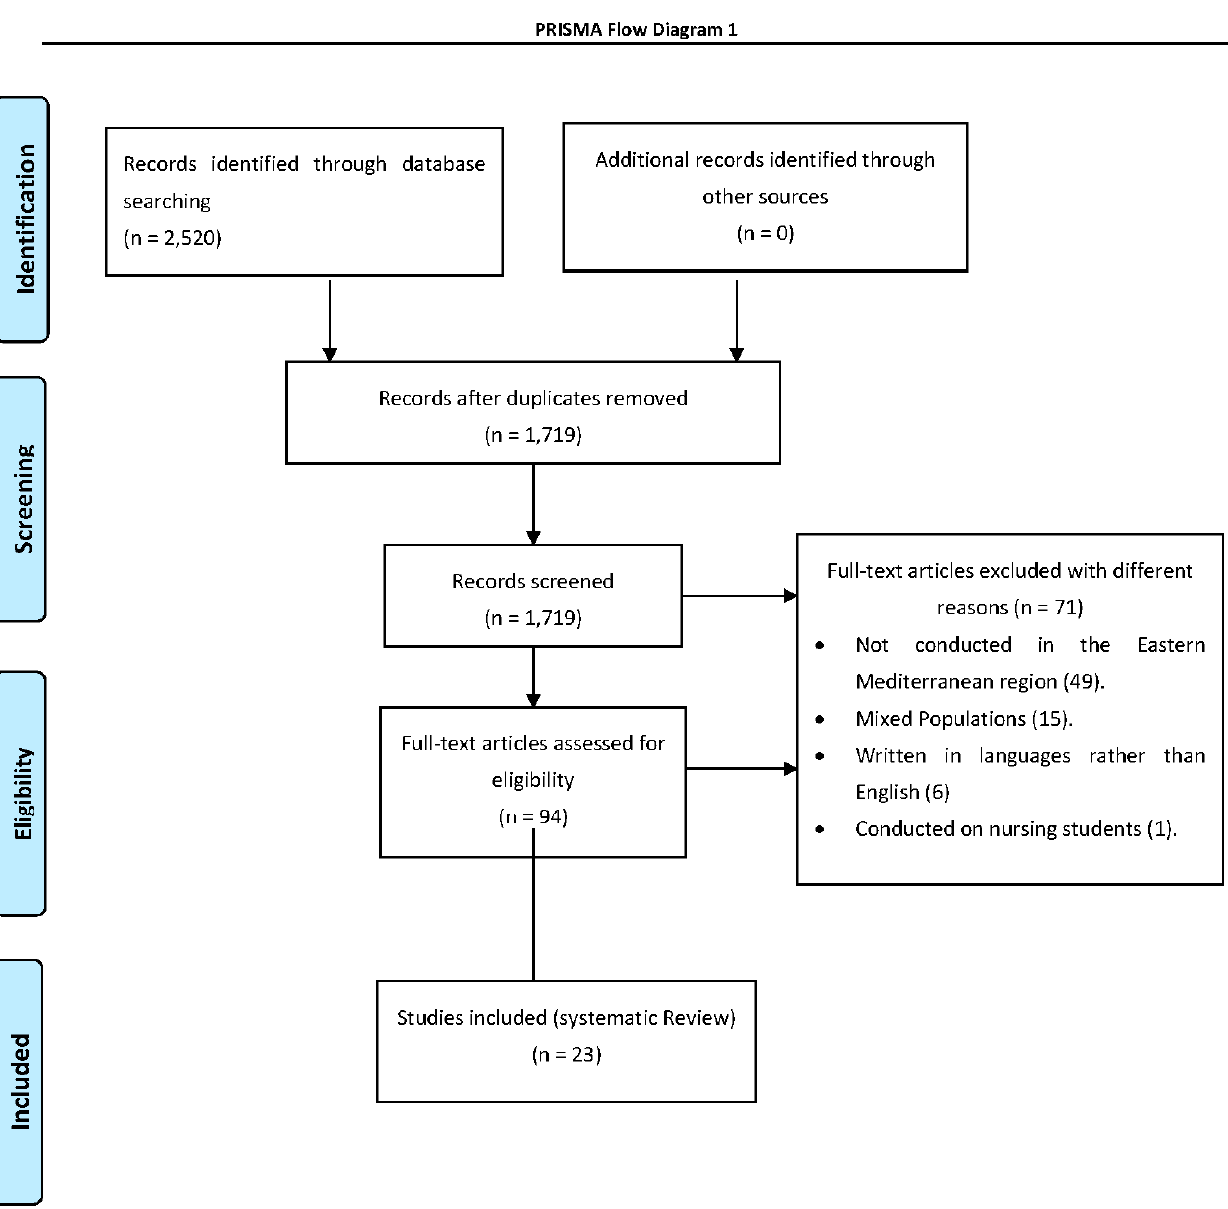
Figure 1. PRISMA Flow Diagram.